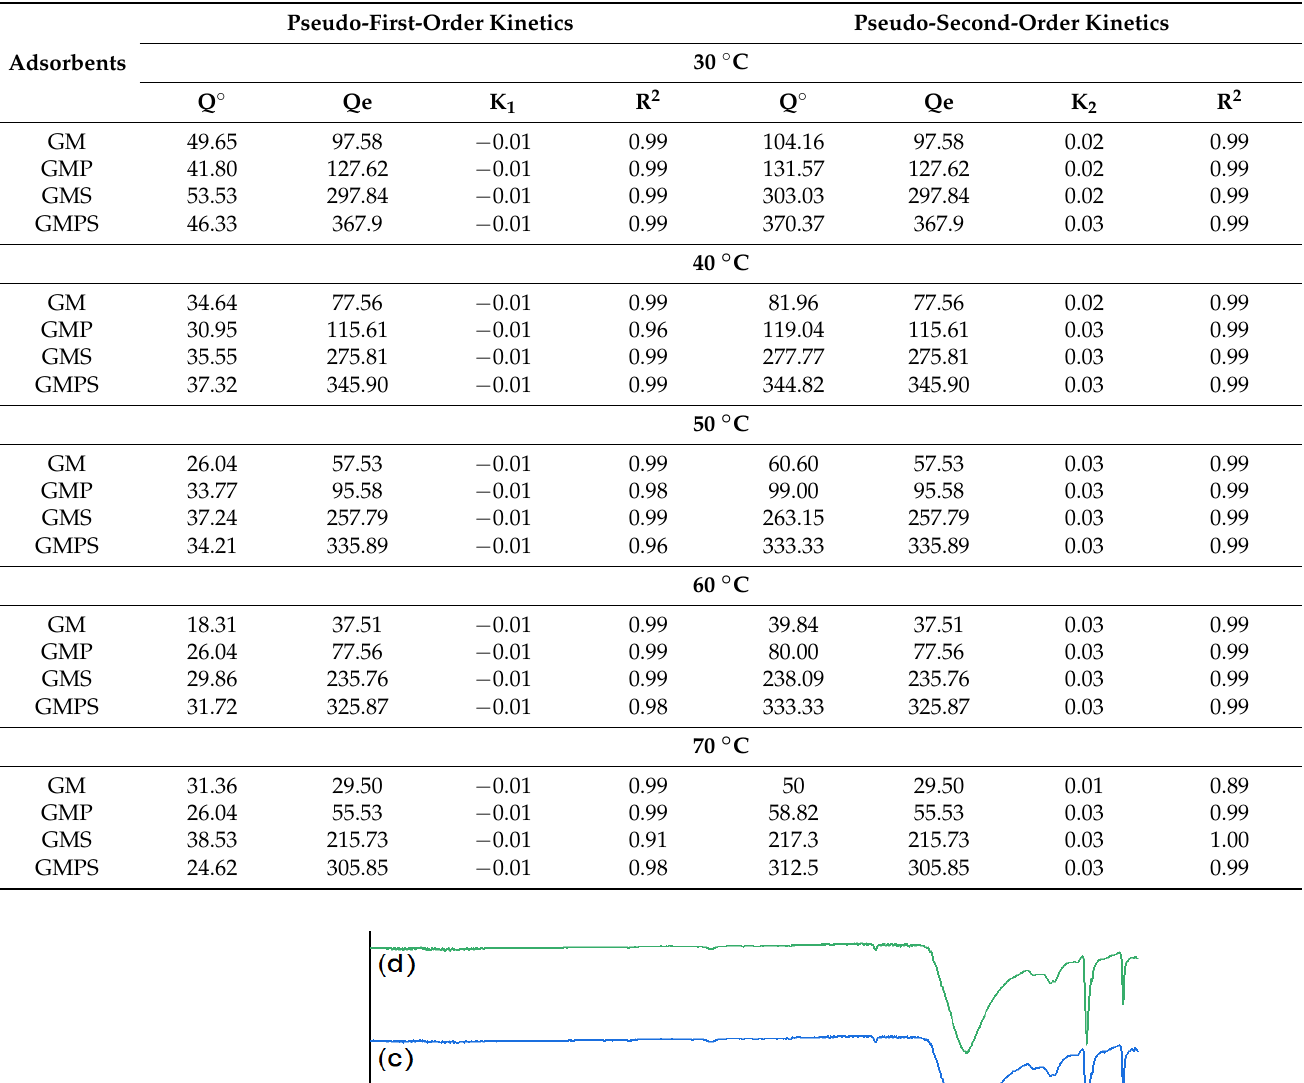
Table 5. Comparison of Pseudo-first-order kinetics and Pseudo-second-order kinetics for Foron blue dye using golden marble waste composites at different temperatures.